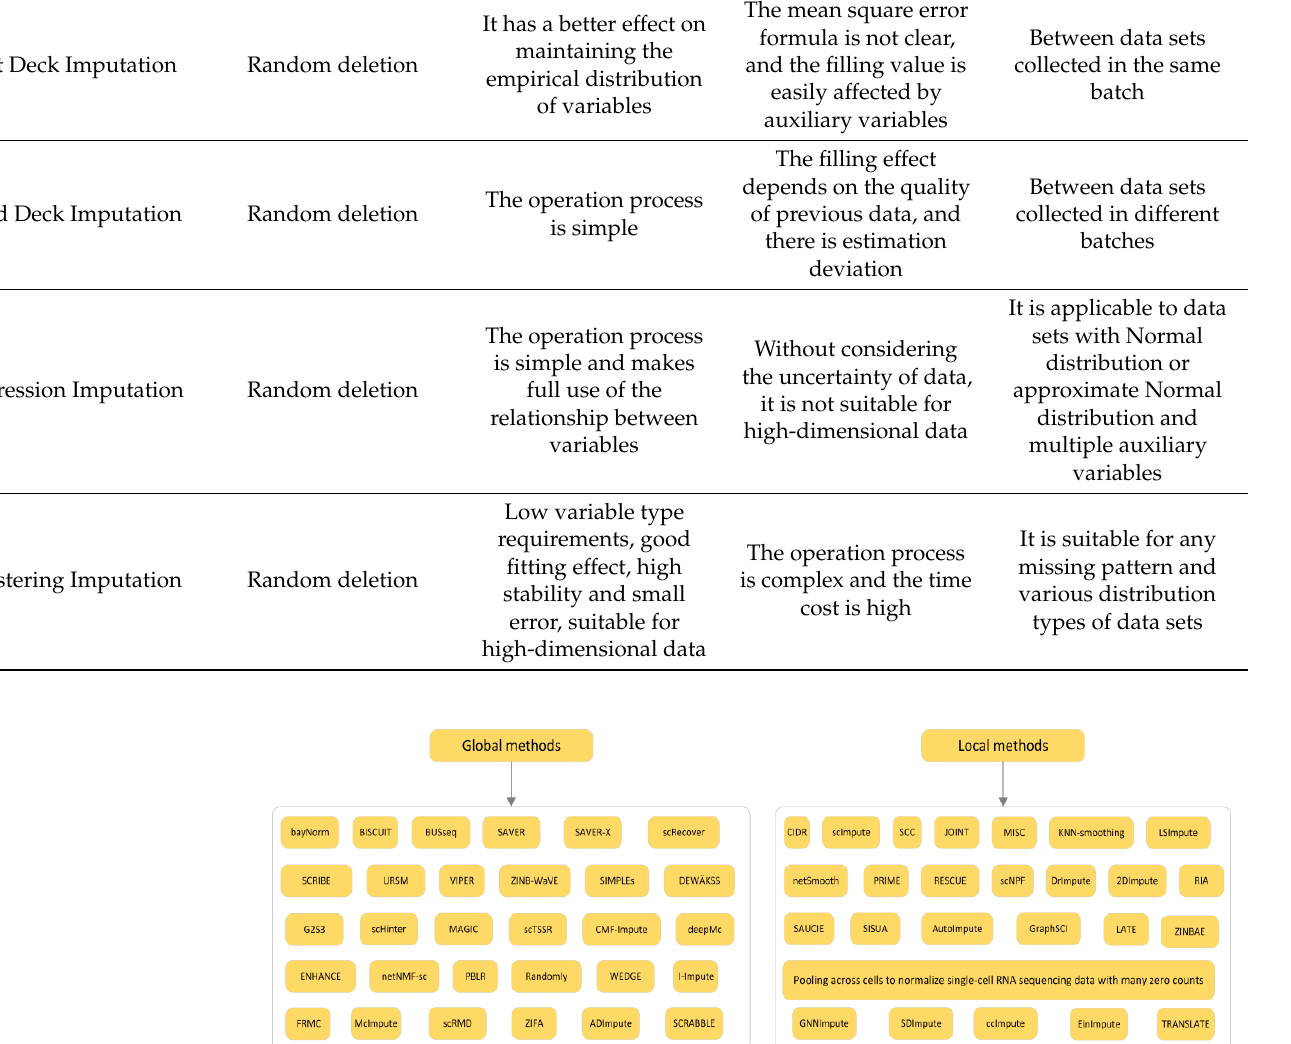
Table 1. Dropout types, advantage and disadvantages and scope of application of “dropout” values of statistical methods and machine learning methods.